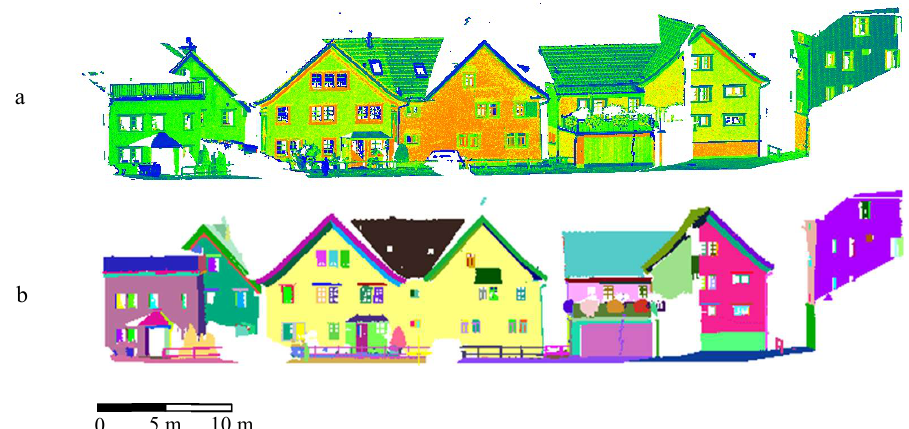
Figure 8. Terrestrial light detection and ranging (LiDAR) data. ( a ) Point cloud published by Zurich Federal Institute of Technology (ETH) Zurich, and ( b ) ground truth data obtained by manual segmentation. Table 1. Parameter settings for experiment using terrestrial laser scanner data.